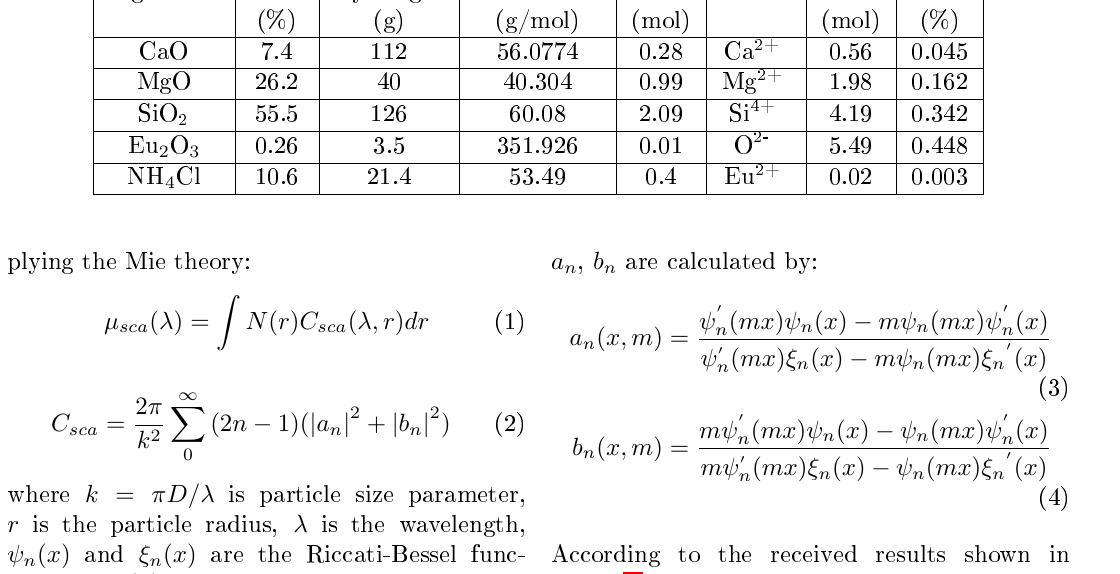
2, the growth of scattering